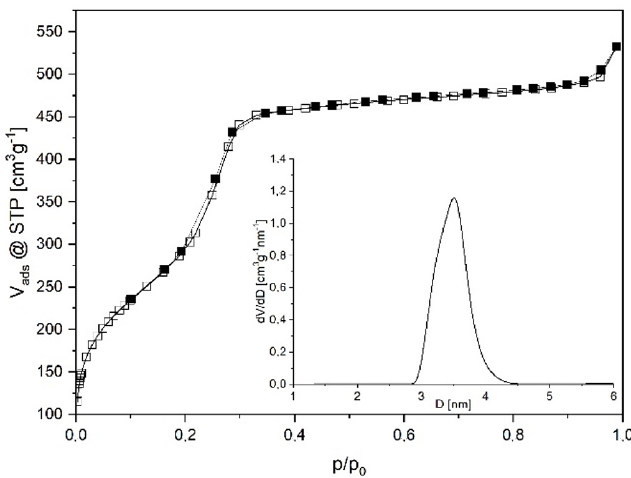
Figure 5. The N 2 adsorption/desorption isotherm and pore size distribution curve of Ti-MCM-41. The N 2 adsorption/desorption isotherm (Figure 5) represents a type IV isotherm according to the IUPAC classification with a sharp inflection at a relative pressure of about 0.3, which is characteristic of capillary condensation within uniform mesopores. A very narrow H1 type hysteresis loop is observed in the relative pressure range of 0.18–0.34. This indicates the very regular mesoporous channels. The DFT pore size distribution curve confirms narrow pore size distribution between 3 and 4 nm. The BET surface area was equal to 1071 m 2 /g and the total pore volume was 0.826 cm 3 /g.